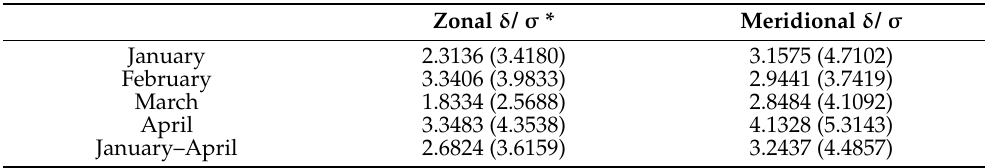
Table 5. Error-related statistics of the retrieved sea ice motion by using FY-3D/MWRI after merging the results of different frequencies and